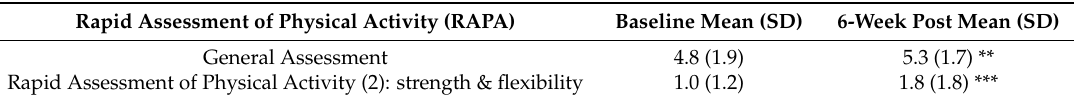
Table 6. Physical Activity Mean